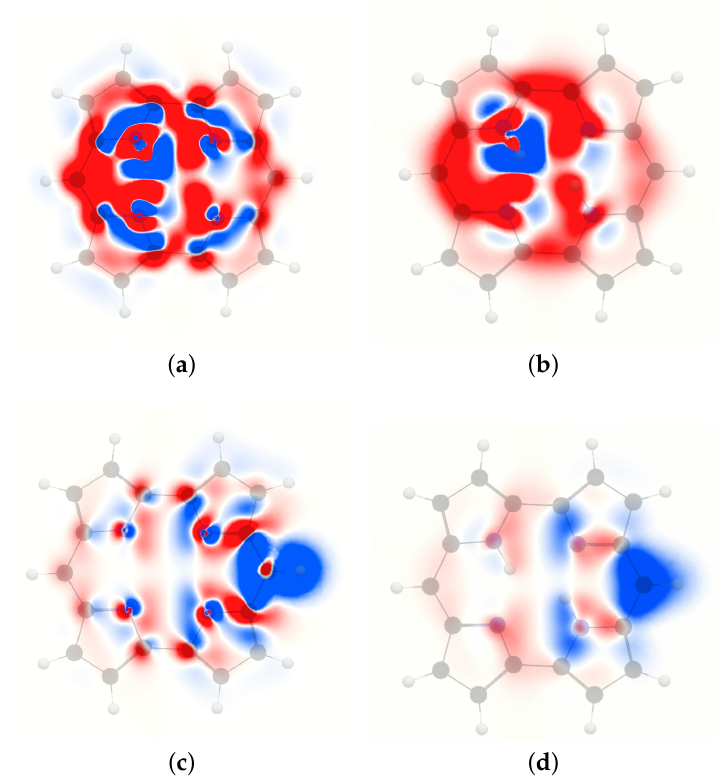
Figure 9. The isotropic 1 H NMR shielding density of the inner hydrogen of trans -norcorrole in ( a ) the molecular plane and ( b ) 1 Å above the plane. The 1 H NMR shielding density of the meso hydrogen in ( c ) the molecular plane and ( d ) 1 Å above the trans -norcorrole plane. The shielding contributions are shown in blue and the deshielding contributions in red. The employed range is [ − 0.2,0.2 ]